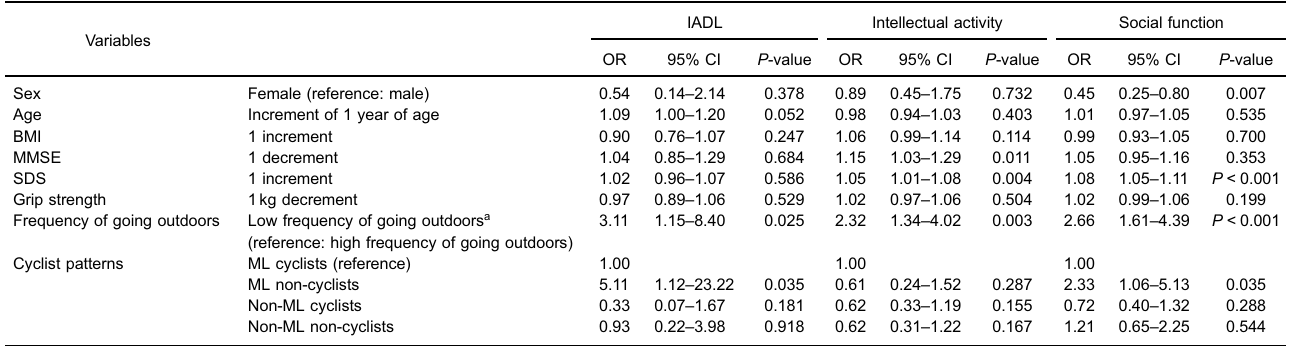
Table 2. Logistic regression analysis of disability in each functional capacity ( n = 614) Variables